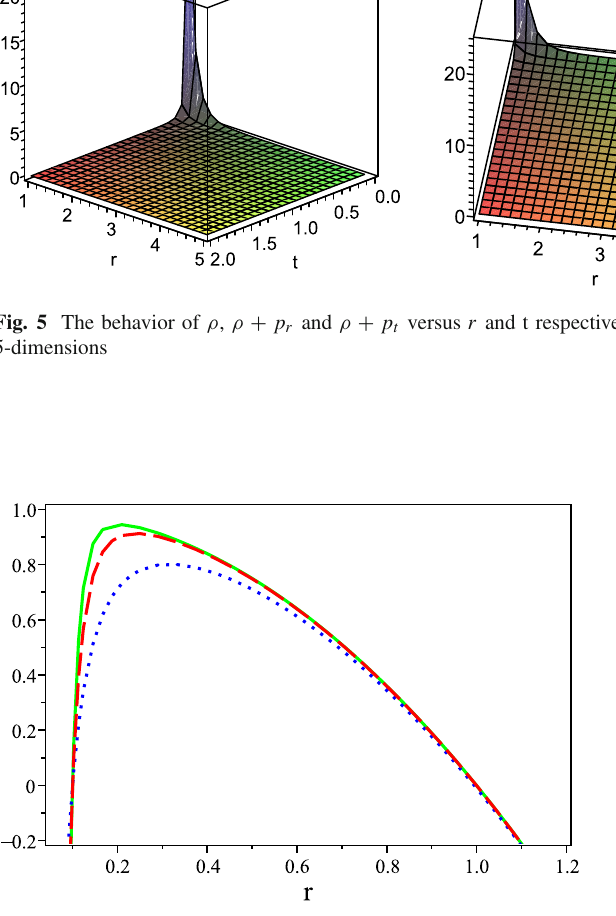
Fig. 6 The behavior of 1 − b ( r )/ r with respect to r for r 0 = 0 . 1, n = 9 , 7 , 5 from up to down,